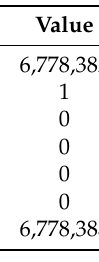
Table 2. Initial conditions for simulations.